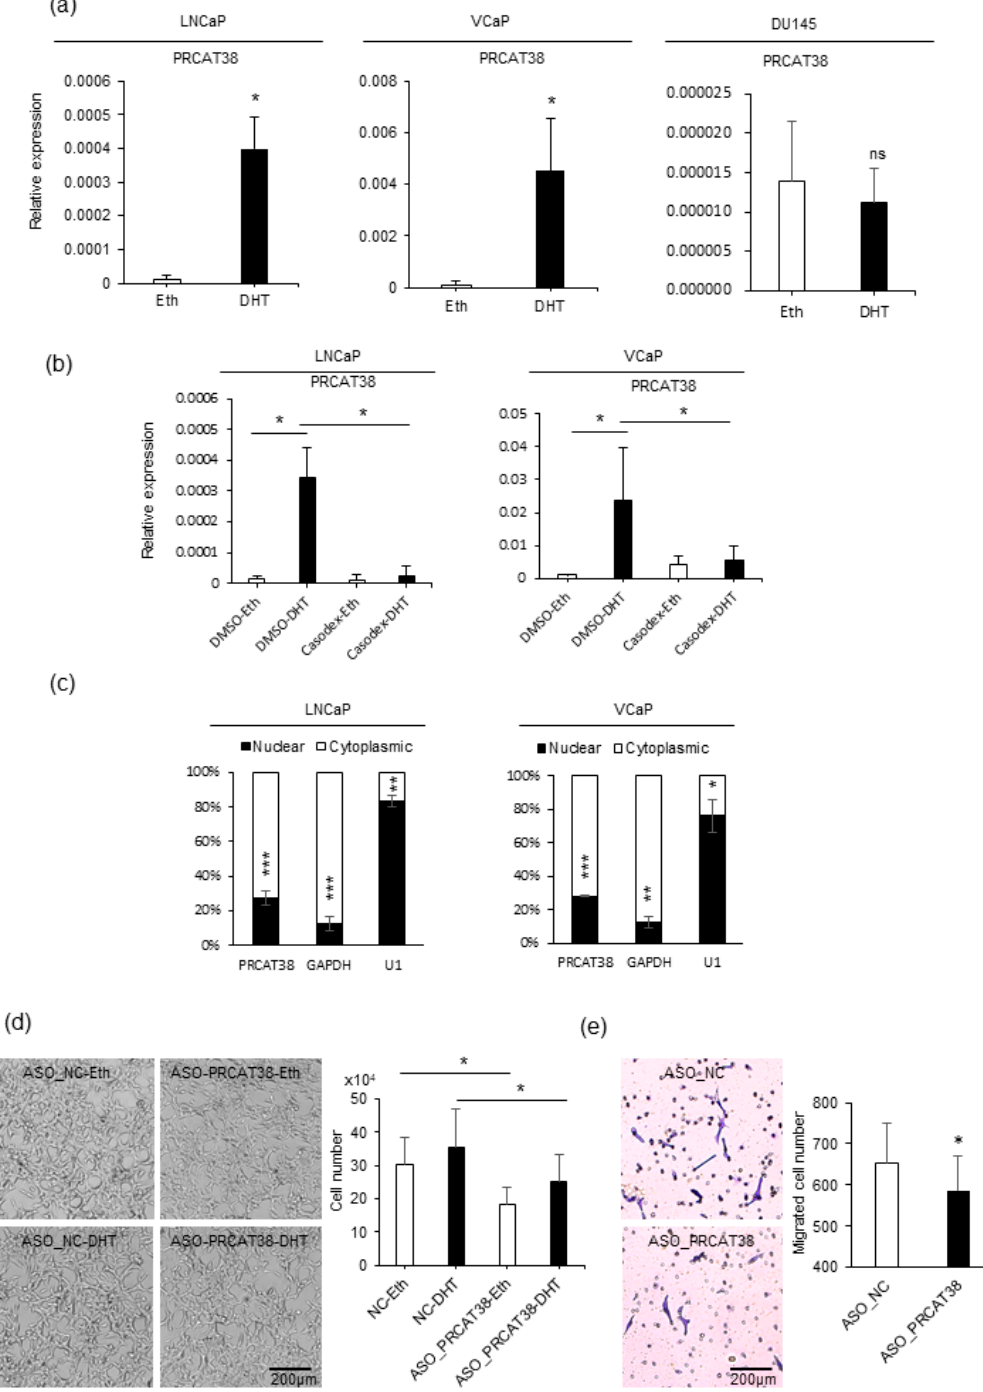
Figure 1. PRCAT38 is an androgen-regulated, prostate cancer-specific lncRNA that modulates cell growth and cell migration. ( a ) PRCAT38 is highly induced by DHT in LNCaP and VCaP cells, but not DU145 cells. ( b ) Androgen induction of PRCAT38 is inhibited by the androgen receptor antagonist bicalutamide in LNCaP and VCaP cells. ( c ) Nuclear-cytoplasmic fractionation showing the subcellular location of PRCAT38 , GAPDH and U1 in LNCaP and VCaP cells. ( d ) growth of LNCaP cells before and after PRCAT38 knockdown. ( e ) Migration of LNCaP cells before and after PRCAT38 knockdown. Data are shown as the mean ± SD (n = 3). *: P < 0.05, **: P < 0.01, ***: P < 0.001, ns: not